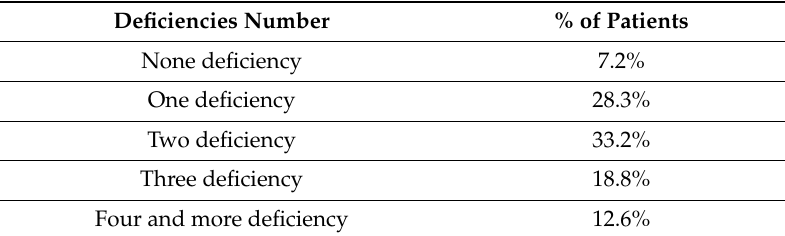
Table 2. Deficiencies detected in AN patients.